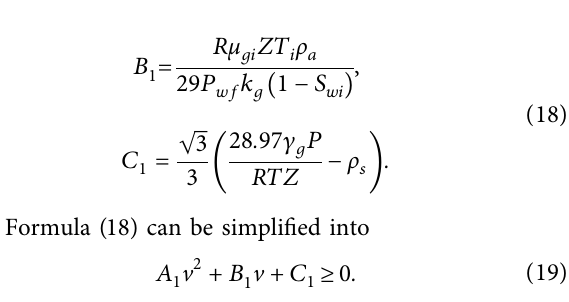
Figure 2: Analysis of proppant stress during gas